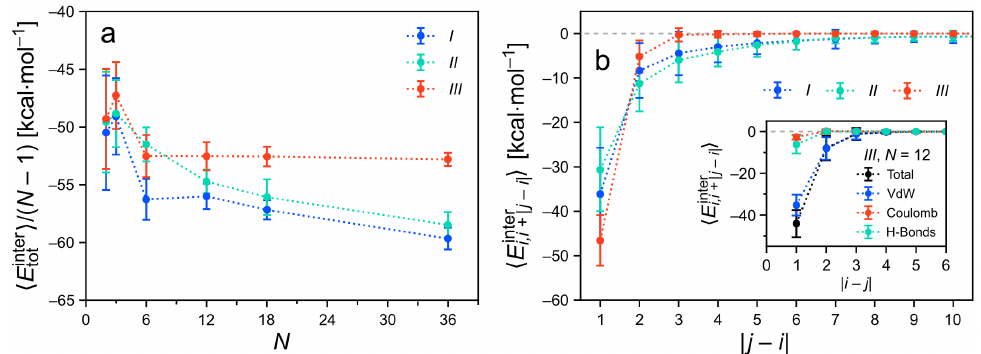
Figure 8. ( a ) Intermolecular energies E inter per neighboring pair of monomers as a function of the tot cluster size N . ( b ) Average intermolecular energy between monomer pairs at separations | j − i | along the stack. Here, only clusters with N > 10 are considered. The inset shows the contributions of the